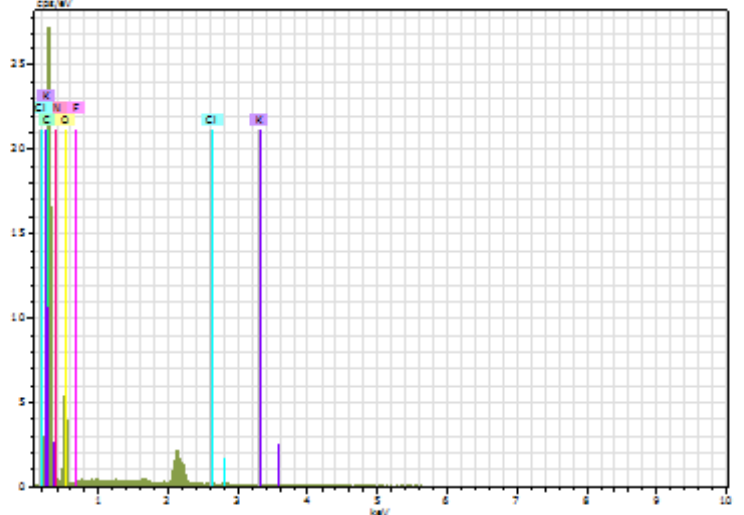
Figure 29. Elemental analysis of composite sample with 0.5% GNP at 1000 rpm .